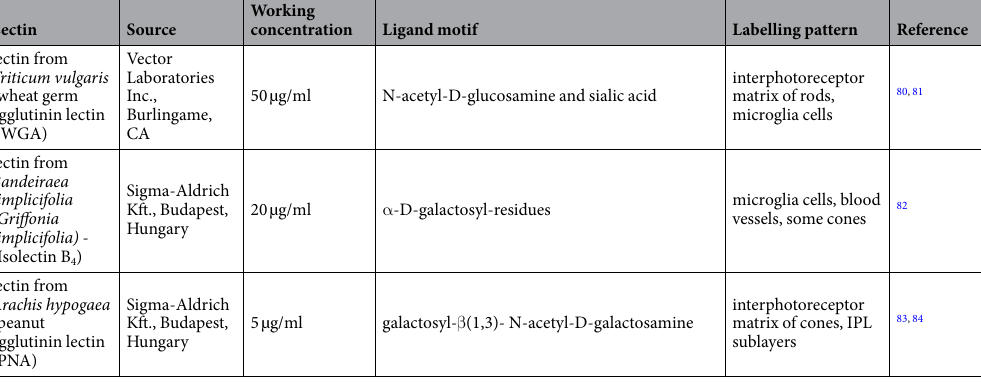
Table 2. Tested lectins and their labelling pattern in the